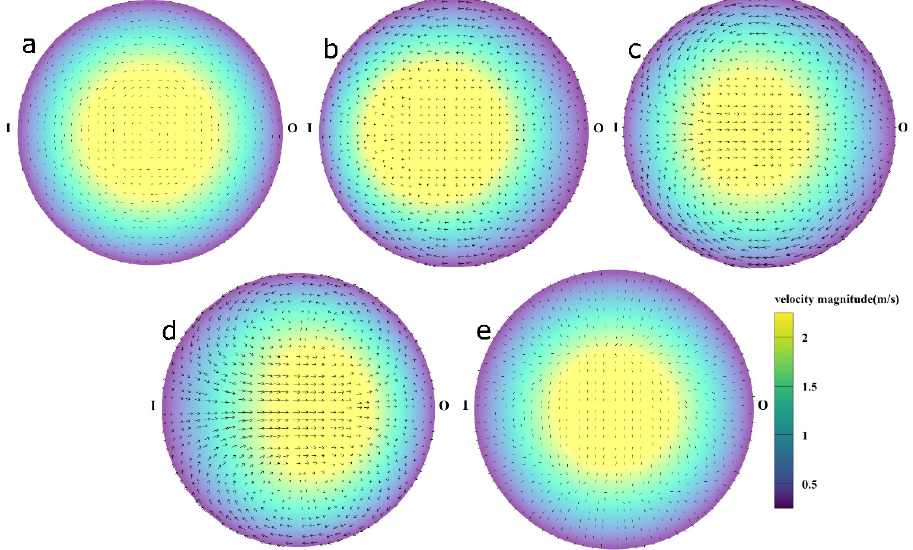
Figure 10. In the 45° channel at the conveying rate of 2.85 cm 3 /s, the profiles of the velocity magnitude and the velocity vectors on the five slices as indicated in Figure 8a. The slices ( a – e ) are from the inlet to the outlet.